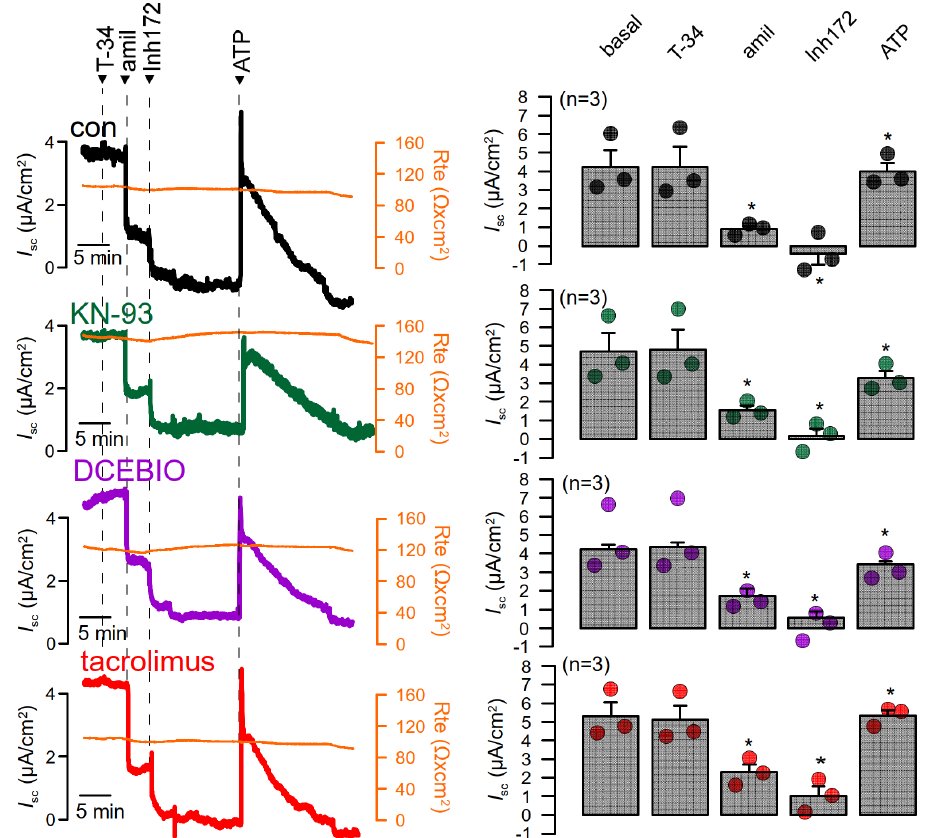
Figure 6. No evidence for CAM, CAMKII, or calcineurin-dependent regulation of endogenous TMEM16A in BCi-NS1 airway epithelial cells. Left panels: Ussing chamber recordings from human BCi-NS1 airway epithelial cells, assessing the ion transport by continuously measuring the transepithelial short circuit current Isc. Original continuous recordings of the short circuit currents Isc in the absence or presence of different inhibitors. The transepithelial resistance was continuously monitored in parallel. Cells were measured under control conditions or after exposure to KN-93 (10 µ M), DCEBIO (10 µ M), or tacrolimus (100 nM). Right panels: Summaries for the short circuit currents corresponding to continuous Isc recordings shown in the left panels. The effects of TRAM-34 (T-34, 100 nM), amiloride (amil, 10 µ M), CFTRinh172 (Inh172, 20 µ M), and ATP (5 µ M) on Isc